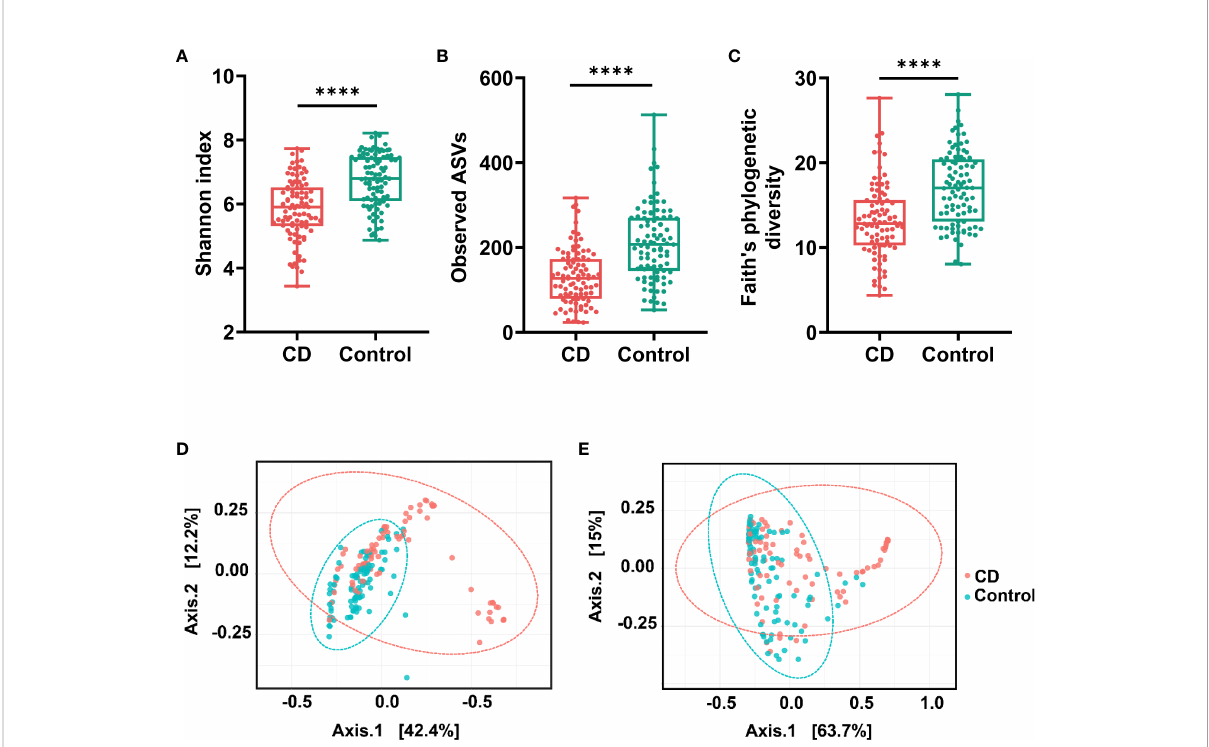
FIGURE 1 a diversities and b diversities in the gut of Crohn ’ s disease (CD) and control groups. Box plots are microbial a diversities in CD and controls. The top and the bottom whiskers indicate the maximum and the minimum values, respectively, and the hyphen represents the median value. The differences of a diversities, including Shannon (A) , observed ASVs (B) , and Faith ’ s phylogenetic diversity (C) at the ASV level were evaluated by paired t-test. b diversities calculated by UniFrac based unweighted (D) and weighted (E) principal coordinate analysis (PCoA). Permutational multivariate analysis of variance (PERMANOVA) was conducted to assess the difference of beta diversity between CD and control group. All comparisons were signi fi cantly different with P < 0.0001. #**** indicates p <